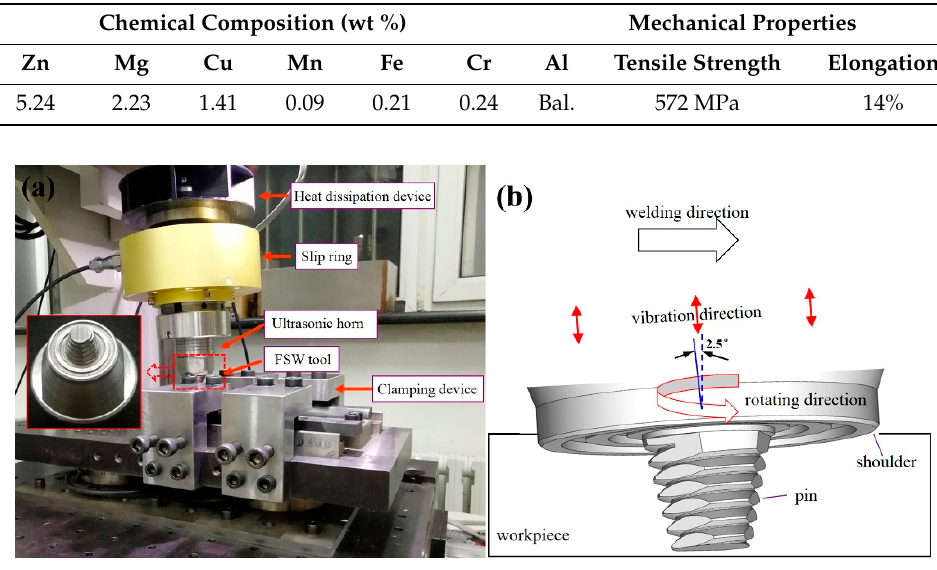
Table 1. Chemical composition and mechanical properties of 7075-T6 aluminium alloy.